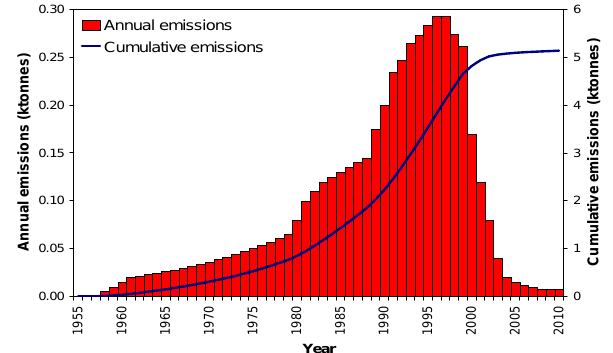
Fig. 3. The observed amounts (symbols) of SF 5 CF 3 in samples col- lected at different depths of firn at the NEEM drilling site, Green- land. The purple line is the result of taking the long-term trend of the gas in the atmospheric model domain box appropriate for NEEM, based on the best fit to Cape Grim (red line in Fig. 1), and used as input to the firn diffusion model.